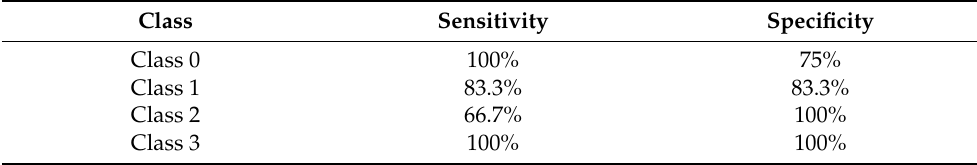
Table 2. The specificities and sensitivities of the developed SVM